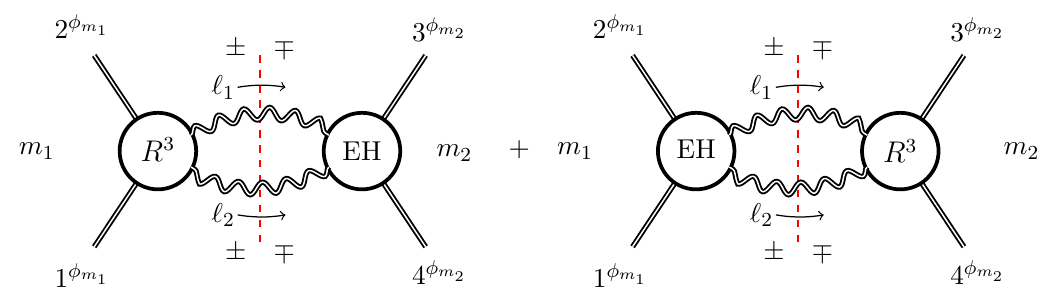
Figure 1 . The two cut diagrams contributing to the leading R 3 correction to the gravitational scattering of two massive scalars. The two gravitons crossing the cut have both either positive or negative helicity and we have indicated this next to the dashed